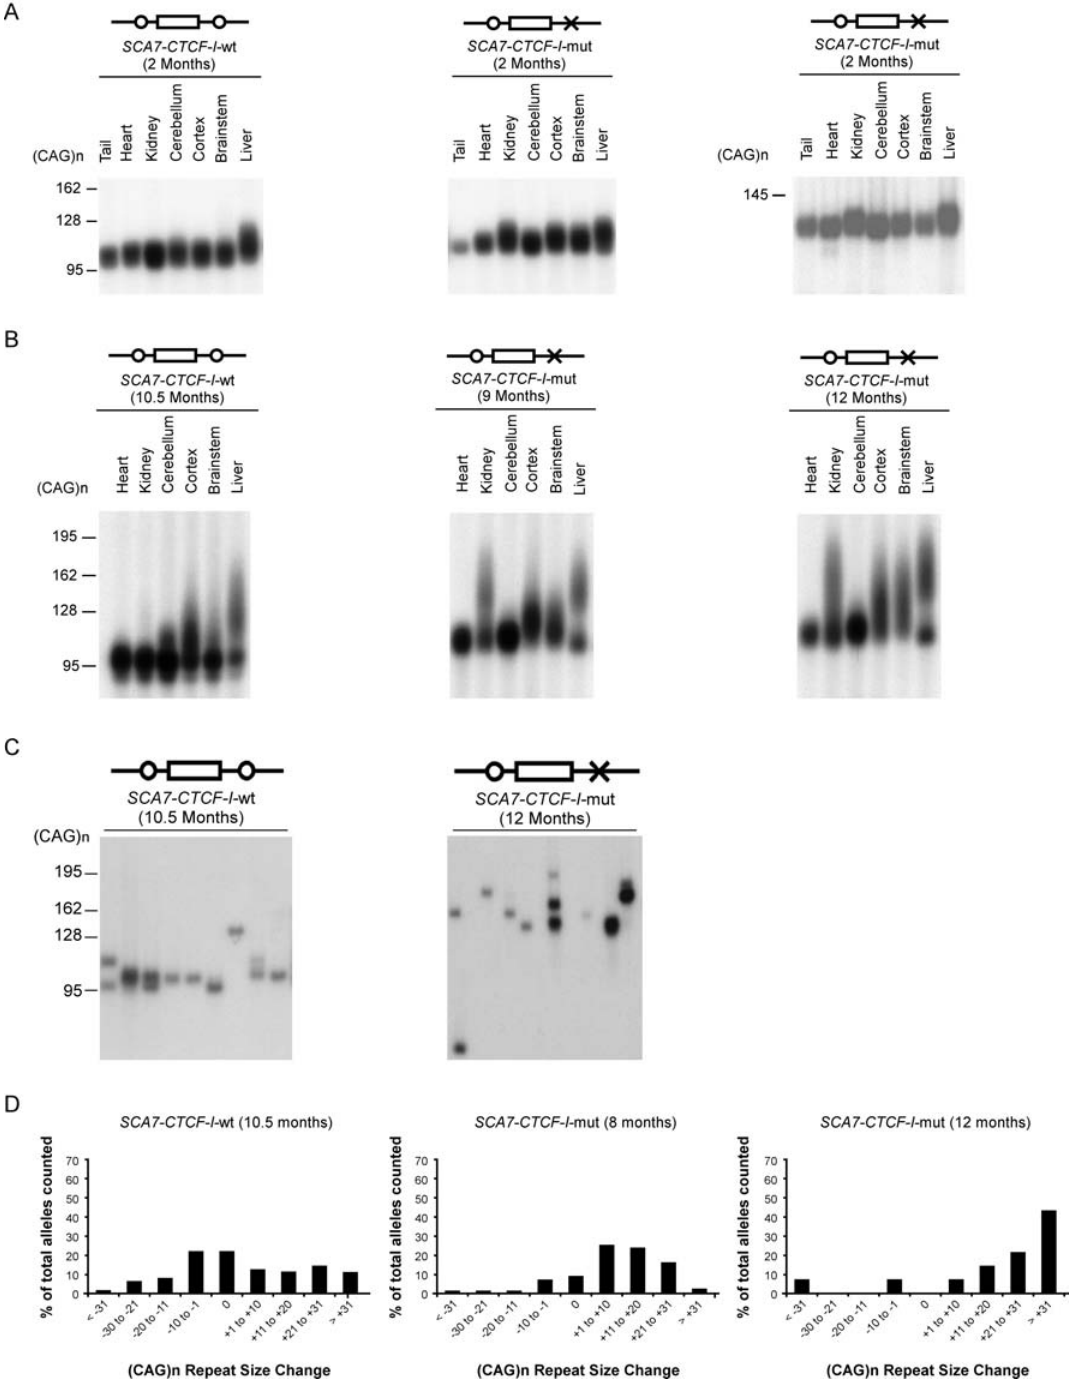
Figure 3. SCA7-CTCF-I -mut mice display increased somatic instability. (A) At 2 months of age, the SCA7 CAG repeat is stable in the SCA7- CTCF-I -wt line and in both SCA7-CTCF-I -mut lines. (B) With advancing age, tissue-specific instability is seen in SCA7-CTCF-I -wt mice; however, this tissue-specific instability is much more pronounced in SCA7-CTCF-I -mut mice. Results for individuals from the two different SCA7-CTCF-I -mut mice are shown here. (C) To permit quantification of somatic instability, we performed small-pool PCR on tissue DNA samples from SCA7-CTCF-I -wt and SCA7- CTCF-I -mut mice. As shown here for cortex, SCA7-CTCF-I -mut mice displayed significantly greater instability than SCA7-CTCF-I -wt mice (p=8.6 6 10 2 5 , Mann-Whitney two-tailed test). See Table 1 for a compiled list of repeat alleles. (D) Histogram of repeat length variation in the cortex of SCA7-CTCF-I - wt and SCA7-CTCF-I -mut mice. SCA7-CTCF-I -mut mice exhibit significantly greater instability than SCA7-CTCF-I -wt mice, and this expansion tendency exceeds that of SCA7-CTCF-I -wt mice, even when 2.5 months younger (p=0.0003, Mann-Whitney two-tailed test). With advancing age, the expansion bias between the SCA7-CTCF-I -mut and -wt mice becomes more pronounced (p , .0001, Mann-Whitney two-tailed test). Results for individuals from the two different SCA7-CTCF-I -mut mice are shown here.